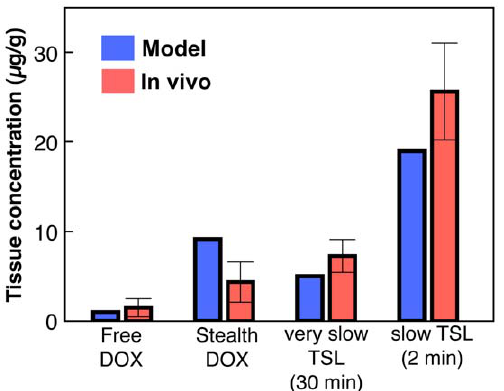
Figure 12. Comparison of mathematical model to a prior in- vivo study [ 12 ] (note that the fast TSL-i formulation discussed above was not employed in this prior study). Free-DOX and Stealth-DOX were compared without hyperthermia; for the two TSL-i- DOX formulations, 1 h hyperthermia was assumed. Administered dose was 5 mg/kg (compared to 9 mg/kg in all other